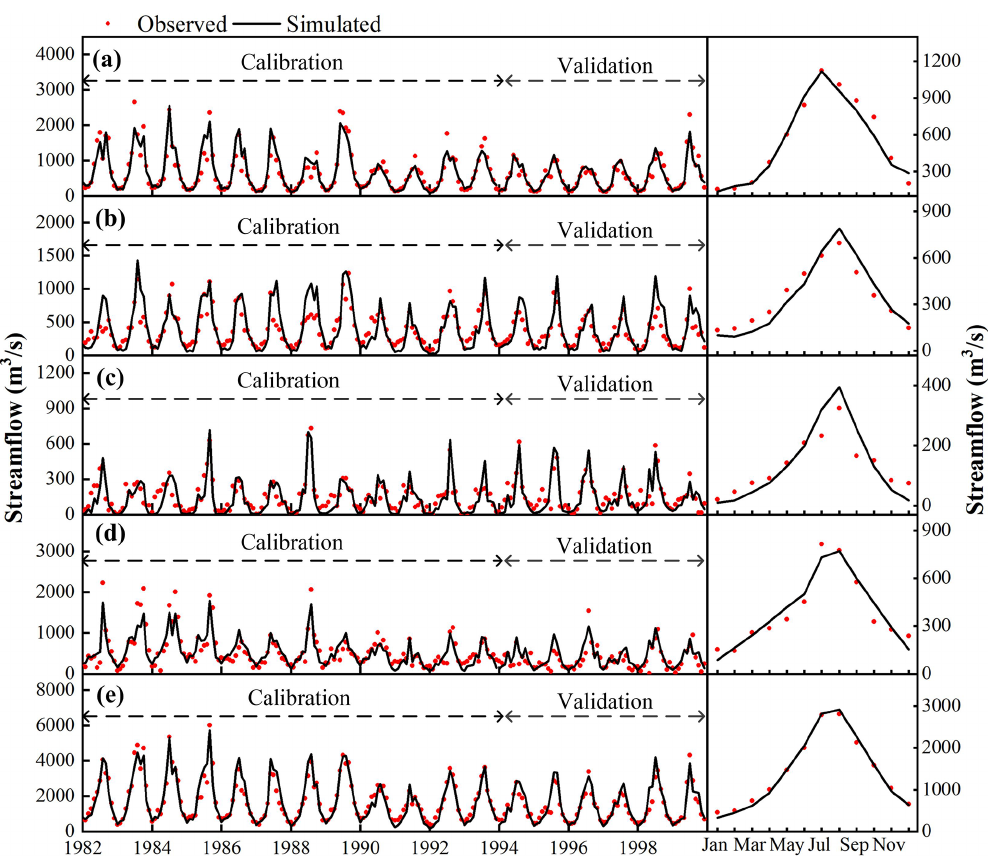
Figure 8. Comparisons of monthly streamflow and seasonal cycles of streamflow simulated by VIC and naturalized streamflow for different drainage areas during 1982–1999. (a) TNH, (b) TNH–TDG, (c) TDG–LM, (d) LM–HYK, (e) HYK.